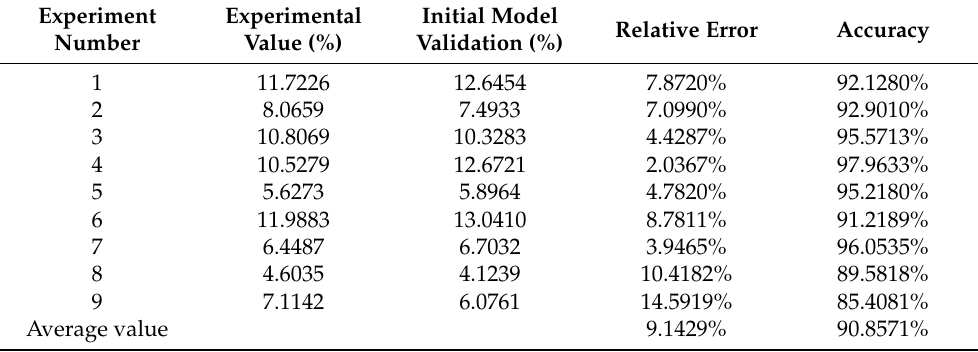
Table 7. Initial model